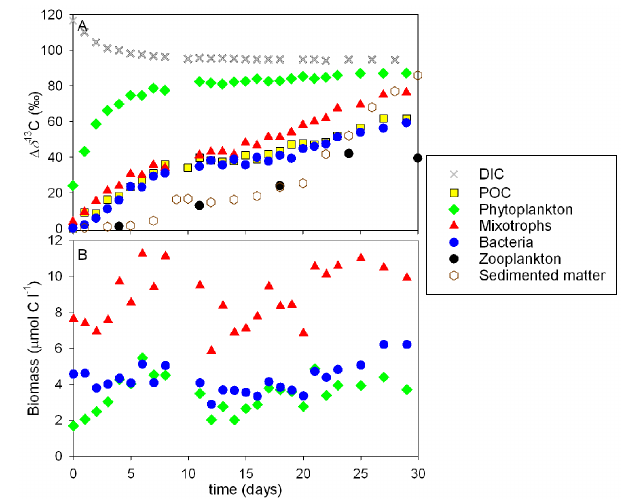
Fig. 1. The temporal change as averaged over all mesocosms ( n = 9) of (A) isotope ratios ( 1δ 13 C) of all measured carbon pools, and (B) of biomass (µmolCL − 1 ) of phytoplankton, mixotrophs, and